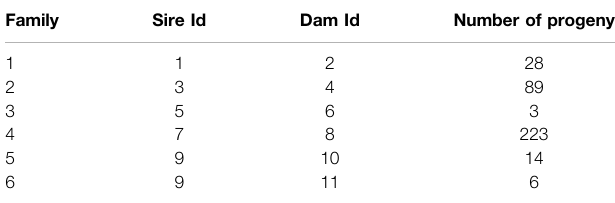
TABLE 1 | Matings and number of individuals randomly sampled from a common tank.